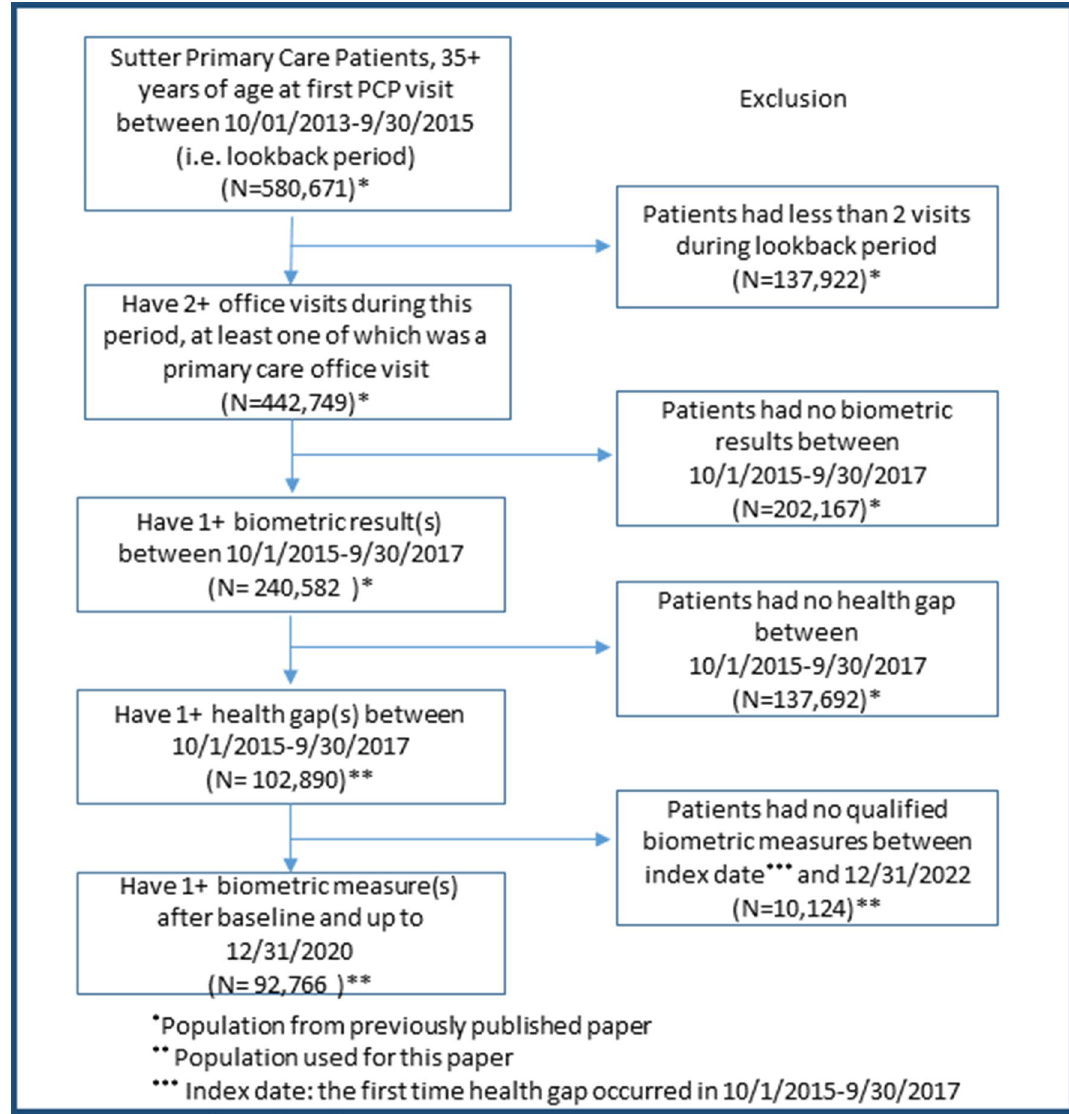
Figure 1. Flowchart for study cohort identification. Data flowchart for patients meeting study eligibility criteria and cohort